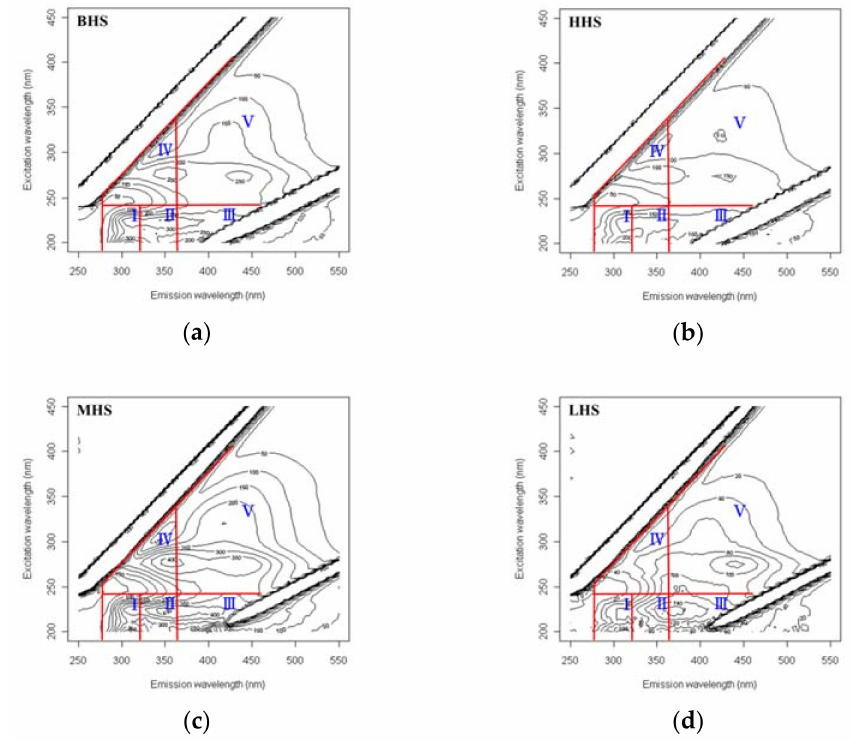
Figure 2. EEM diagrams of bulk and size-fractioned SHS with the air-dry method and the FRI regions: ( a ) BHS, ( b ) HHS, ( c ) MHS, and ( d )